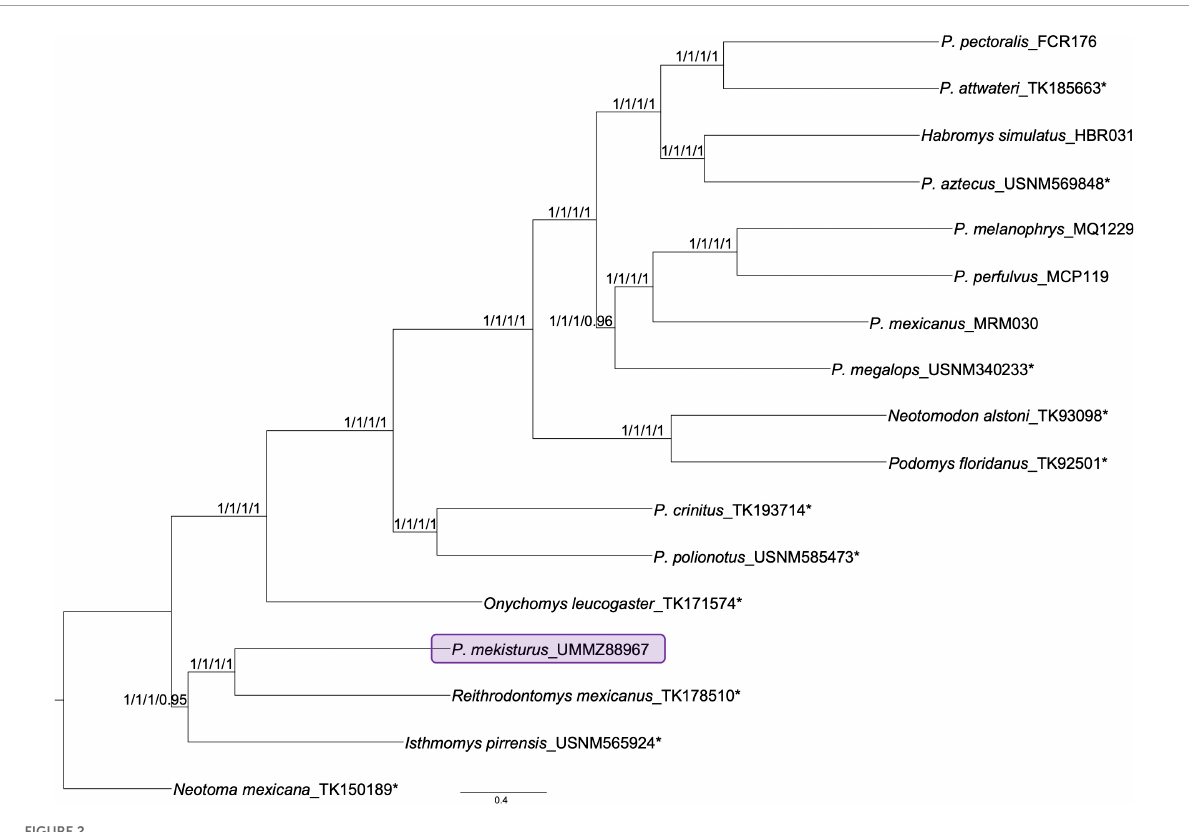
FIGURE2 ASTRAL species tree estimation based on different levels of matrix completeness (65% − 3,649 UCE loci − , 75% − 3,361 UCE loci − , 85% − 2,155 UCE loci − , and 95% − 417 UCE loci − ) and the N = 17 dataset. Nodal support is provided with local posterior probability in the same order as the matrices were mentioned. Note that the phylogenetic position of the P. mekisturus specimen collected in 1947 (purple block) also shows strong support for its close relationship to R. mexicanus . Asterisks* denote specimens that were sequenced from museum specimens for this